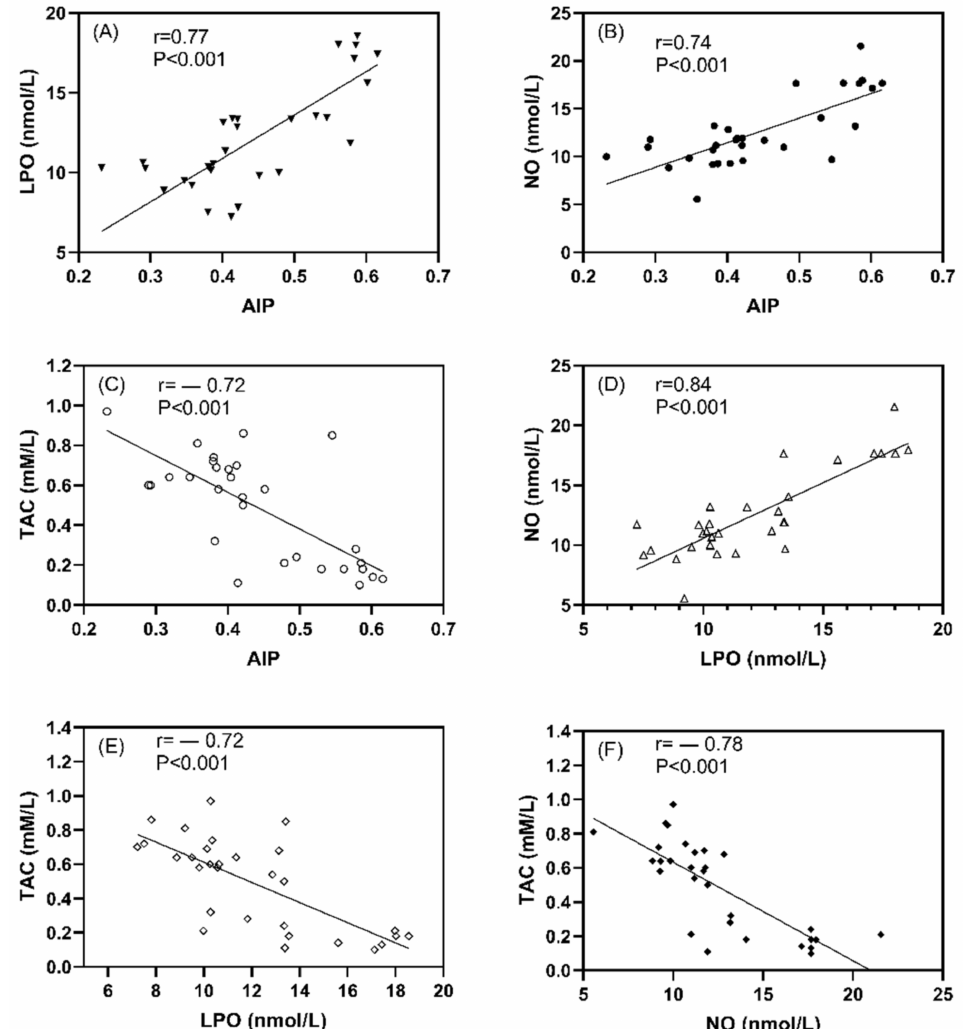
Figure 5. The correlation coefficient between studied oxidative stress markers and atherogenic index plasma in all studied rats; ( A ) LPO vs AIP, ( B ) NO vs AIP, ( C ) TAC vs AIP, ( D ) NO vs LPO, ( E ) TAC vs LPO, and ( F ) TAC vs NO. Data expressed as correlation coefficient (r) values and p < 0.001 indicates the significant difference between studied